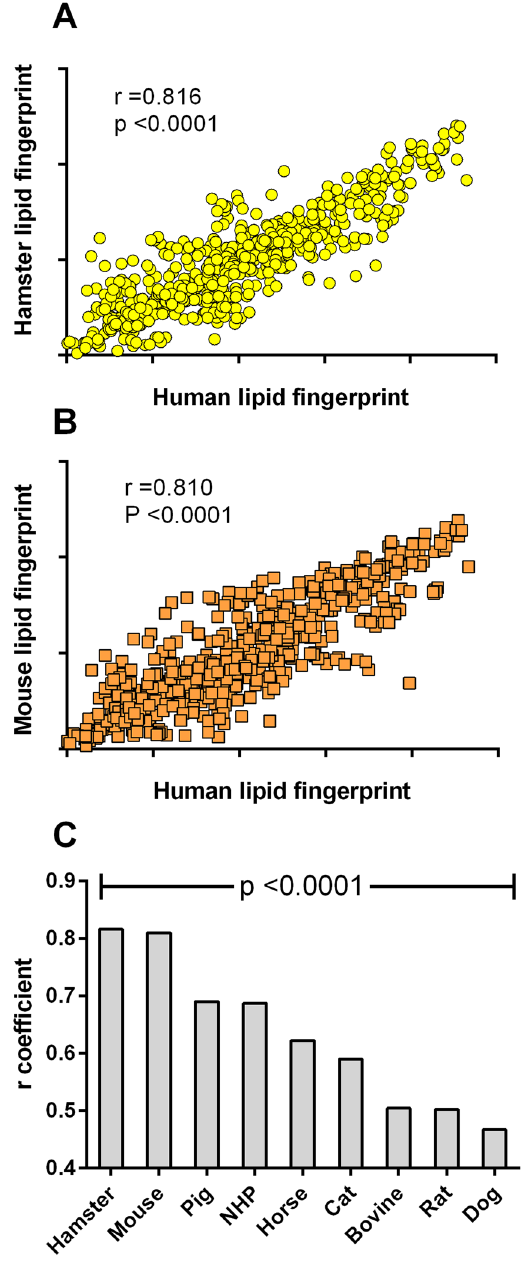
Figure 5. Correlation of lipid marker abundances between human and animals. ( A ) Pearson correlation obtained with the mean relative abundances (n = 6) of identified lipids (n = 106) (A) between hamster and human and (B) between mouse and human. (C) Pearson correlation coefficients (p < 0.0001) obtained with the relative abundances of identified lipids between human and each animal species (n =